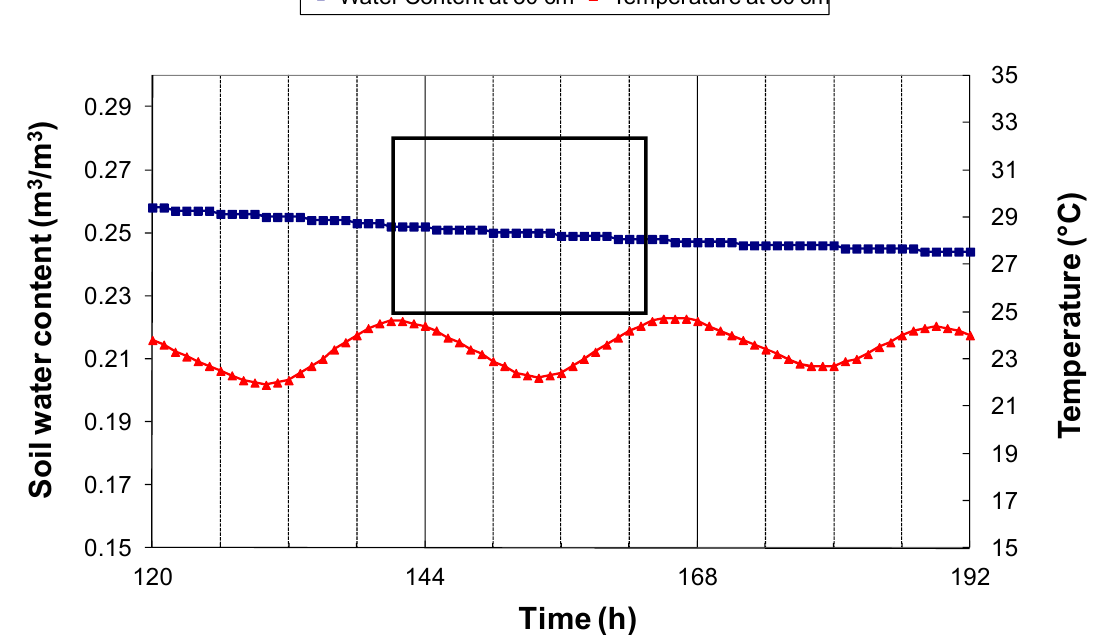
Figure 3. Concurrent simulated variations of soil water content and soil temperature during a drying cycle as calculated by the TEC model for the silt loam soil (CO-SiL). Solid grids at 120, 144, and 168 h correspond to